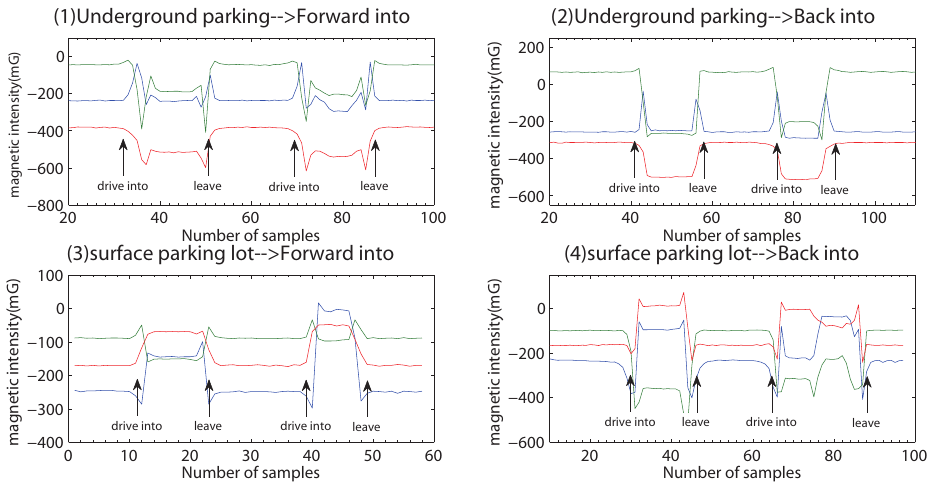
Fig. 3. Magnetoresistive Sensor Data Curves. The blue, red and green lines stand for x -axis, y -axis and z -axis, respectively.